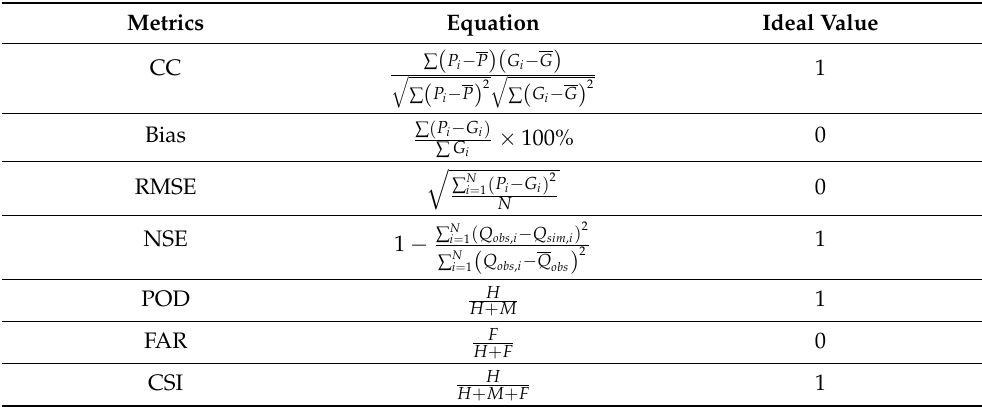
Table 2. Equations and ideal values of the statistical and categorical